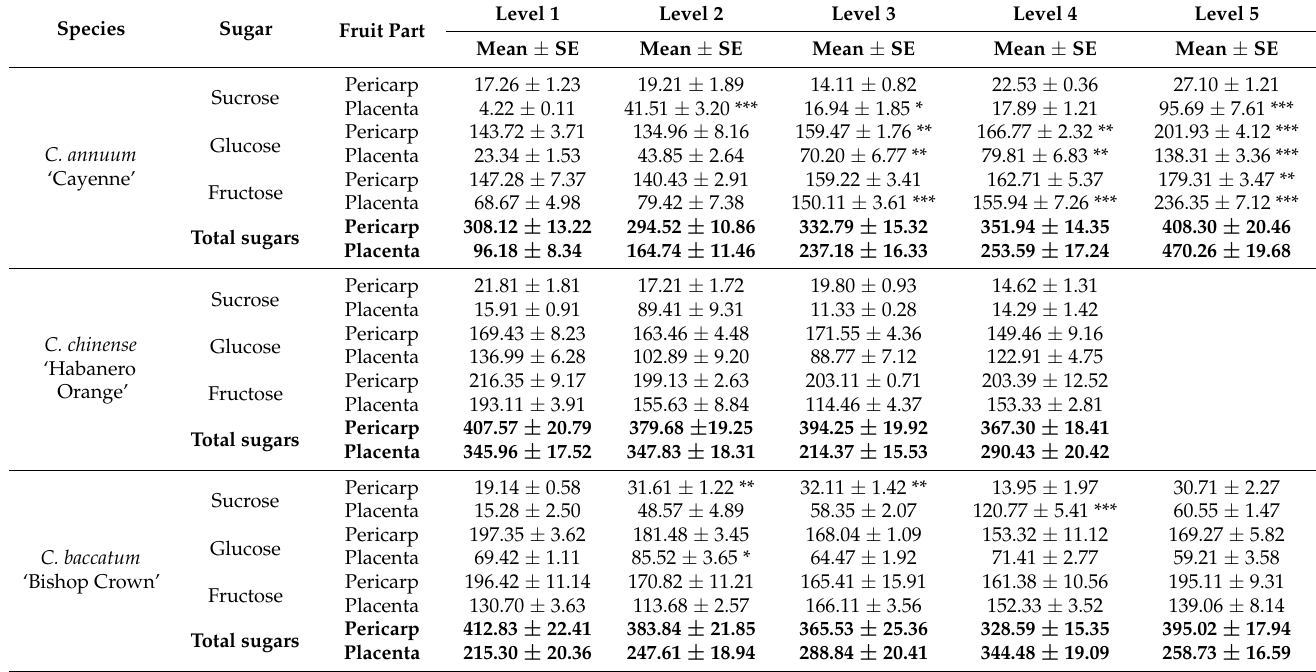
Table 2. Individual and total sugars (g/kg DW; mean ± SE) in three different chili cultivars